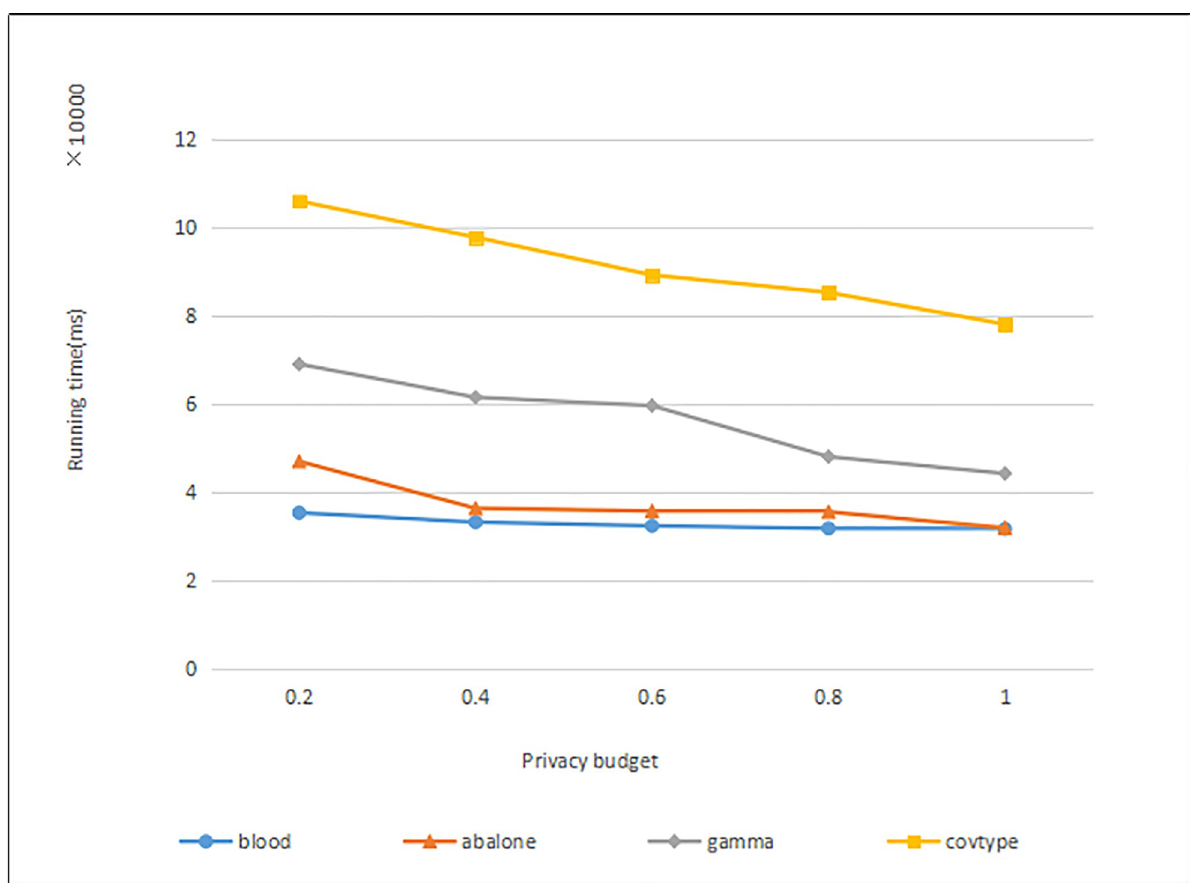
Fig 6. Stability of running time of data sets under different privacy